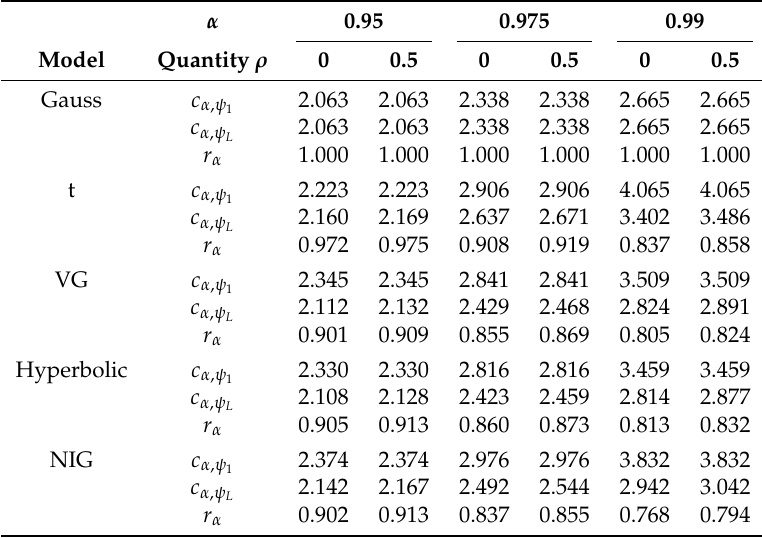
, c α , ψ and ratios r α in the experiment with five risk L 1